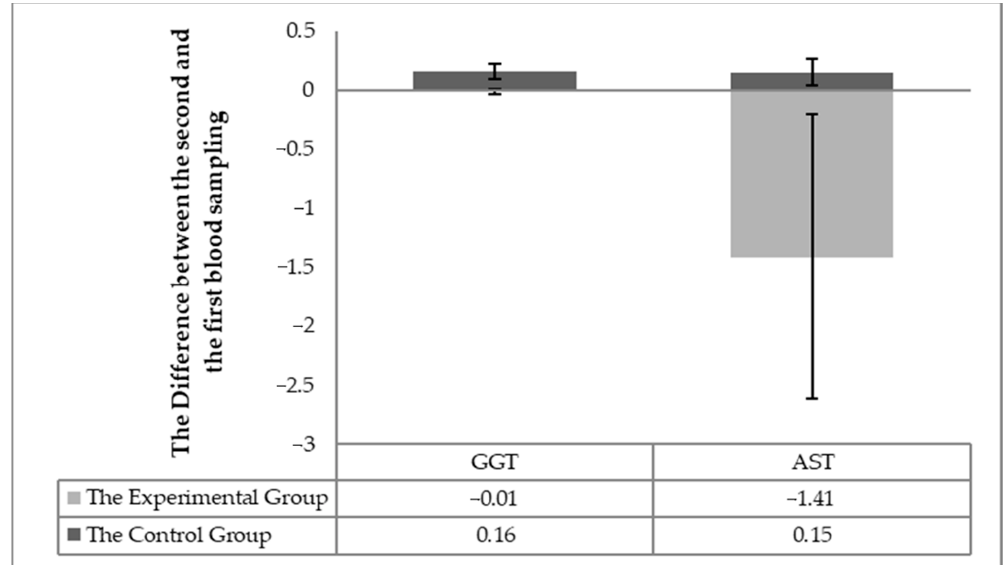
Figure 3. The difference of the monitored parameters (GGT and AST) between the first and the second sampling in the individual horses.